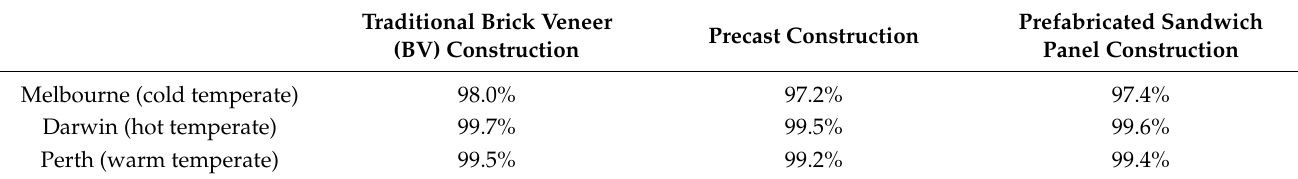
Table 3. Coefficient of Multiple Determination ( R 2